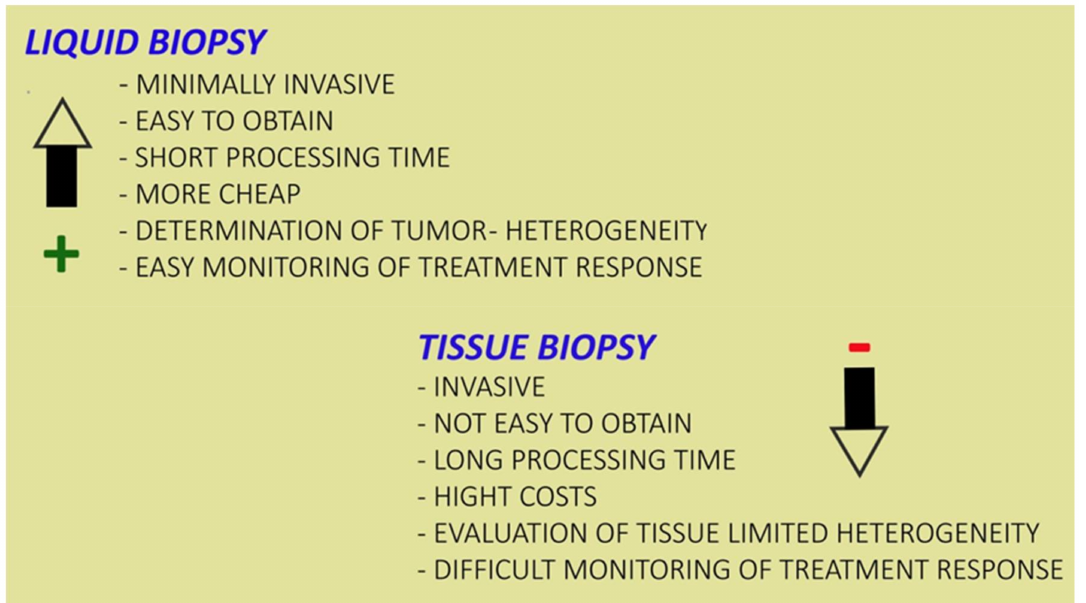
Figure 2. Schematic representation of advantages and disadvantages of liquid and tissue biopsies. + represent advantages of liquid biopsy clinical application, while − represent